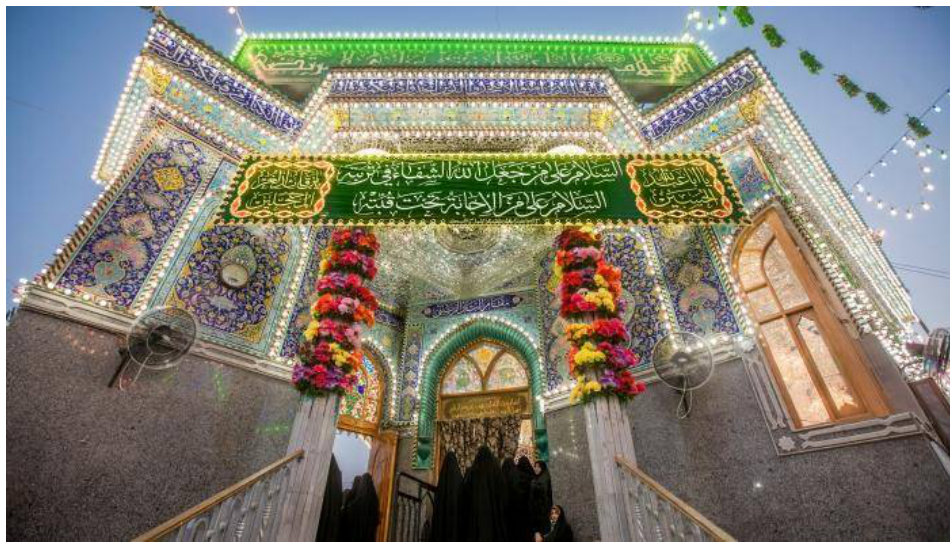
Figure 9. Figure 9. Source: “Al-Zaynabee Hill”, Imam Hussain Holy Shrine (20 May 2018) https:// imamhussain.org/english/karbala/18071 accessed on 1 October 2021. The current mosque is donned with green ornaments and banners. In Shi ʿ i Islam, green symbolises purity, fertility and peace. The dome on the mosque has distinct blue tiling. In Shi ʿ ism, blue symbolises water, tranquillity, heaven, peace of mind, and peacefulness. The marble and grating beneath it are textured with red and white colours. The red, white and blue combination represents a unique contrast. In Shi ʿ ism, white symbolises innocence, peace, perfection and purity of the soul, while red symbolises blood and the continual revolution of Ashura and enemies of the Ahl al-Bayt (Interview with Iranian religio-pragmatics professor, 26 September 2021). In some ways, the Zaynab Hillock dome represents an architectural contrast between good and evil. The circular blue dome represents tranquillity and peacefulness. As in many other faiths, Shi ʿ ism views the circle to be a perfect geometrical shape. The circle represents perfection, sublimity, devoid imperfection and all-inclusivity. For these reasons, the base of domes always takes the form of a circle. Figure 10 captures this contrast between good and evil.